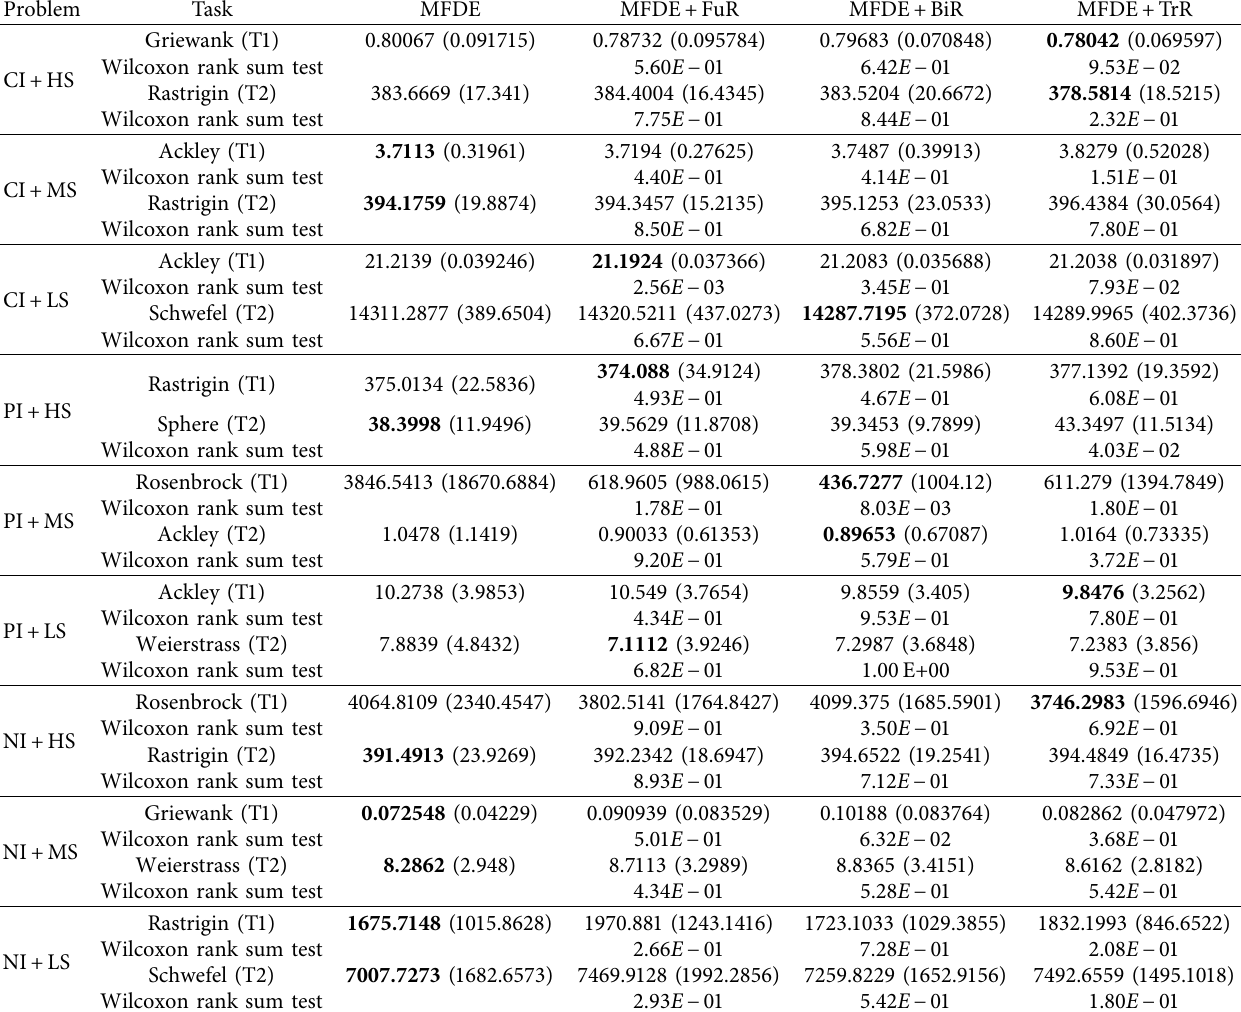
Table 3: Results obtained by MFDE under different order of